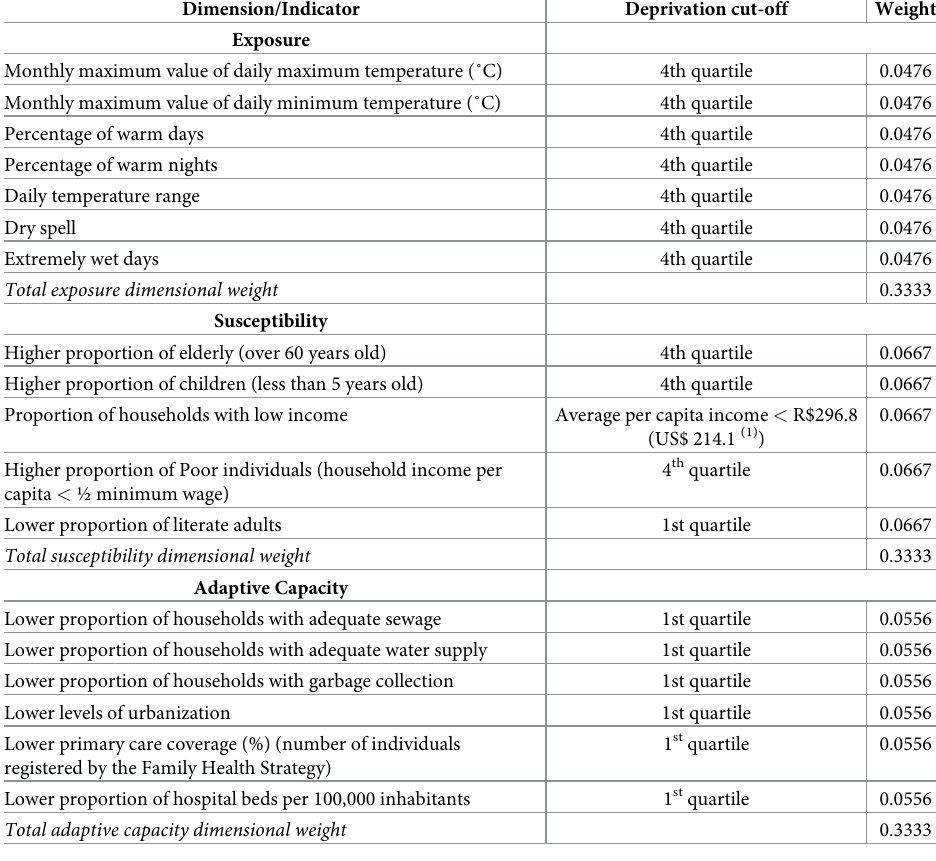
Table 1. Cut-offs and weights attributed to each indicator of